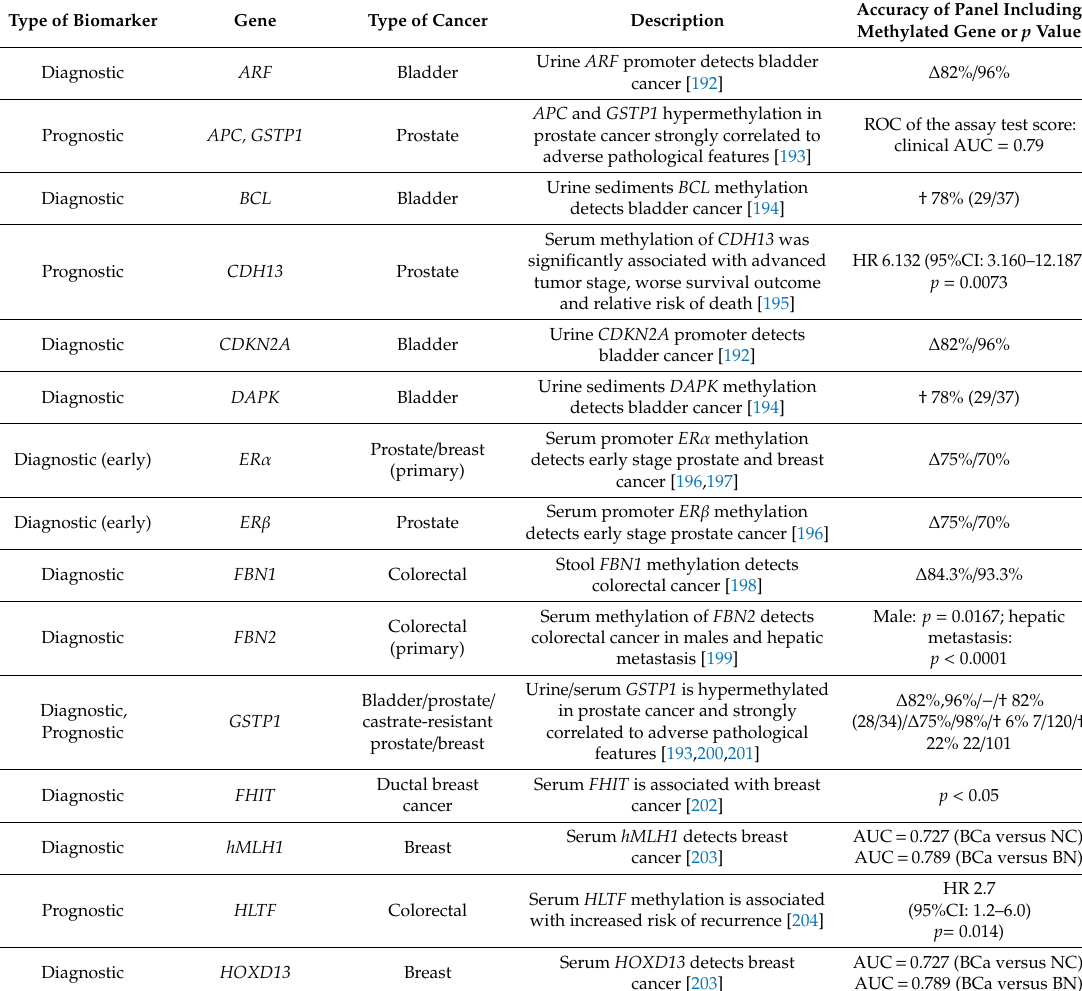
Table 4. Examples of the relevancy of DNA methylation alterations as non-invasive diagnostic and prognostic biomarkers in